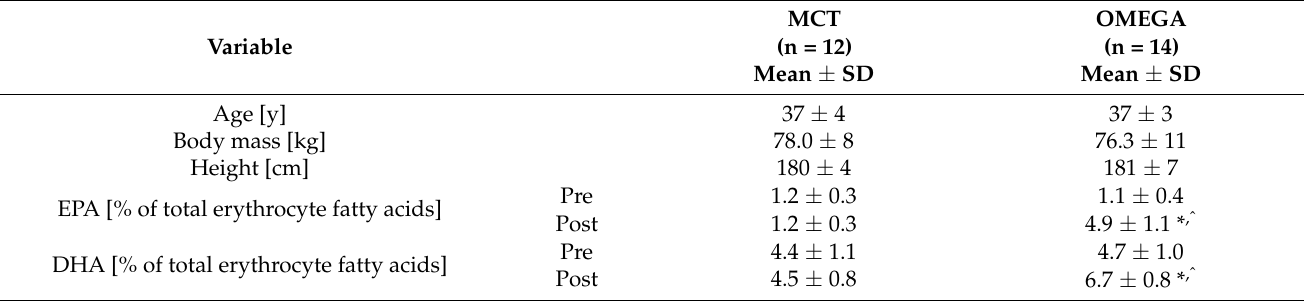
Table 1. Characteristics of